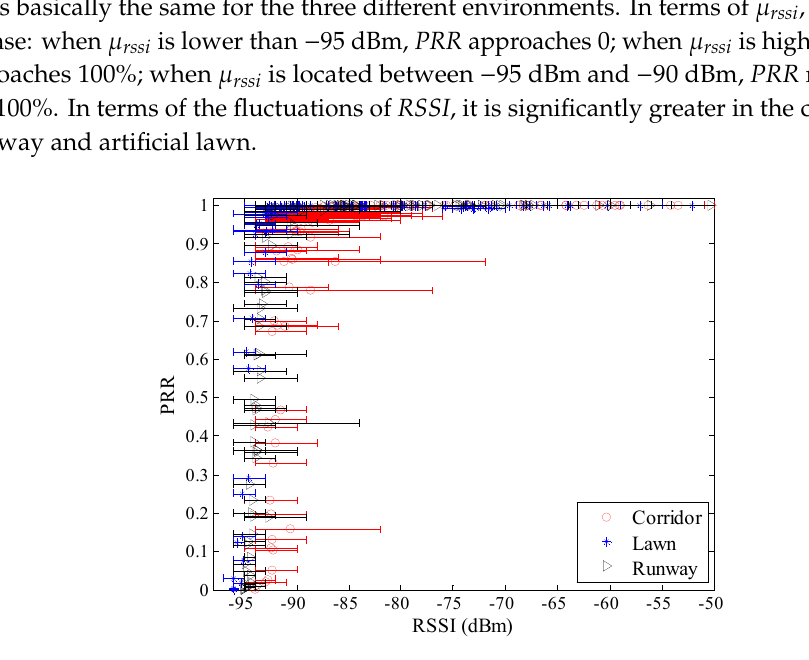
Figure 8. μ rssi vs. PRR in different environments.